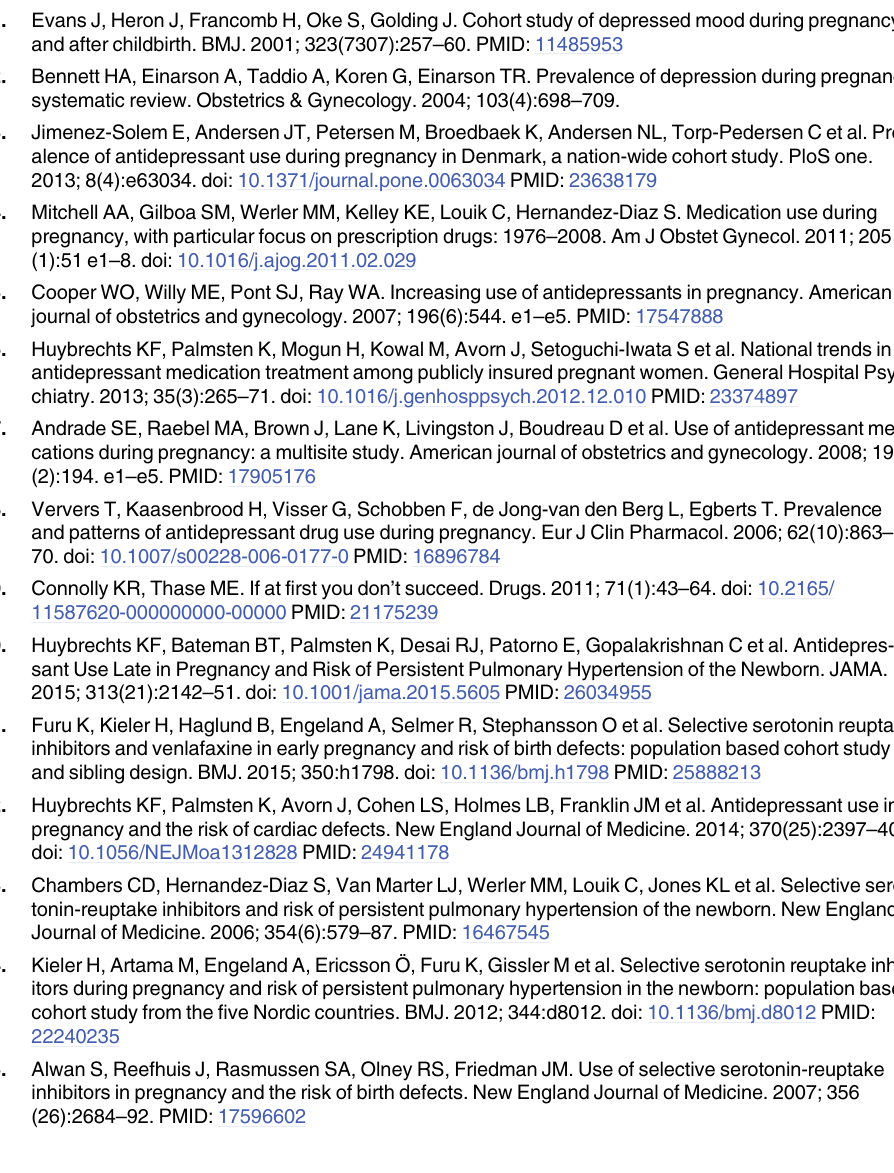
S1 Table. Categorization of antidepressants with defined daily doses (DDDs) and fre- quency of prescription fills (N) for each substance. SSRIs, selective serotonin reuptake inhibi- tors; SNRIs, serotonin – norepinephrine reuptake